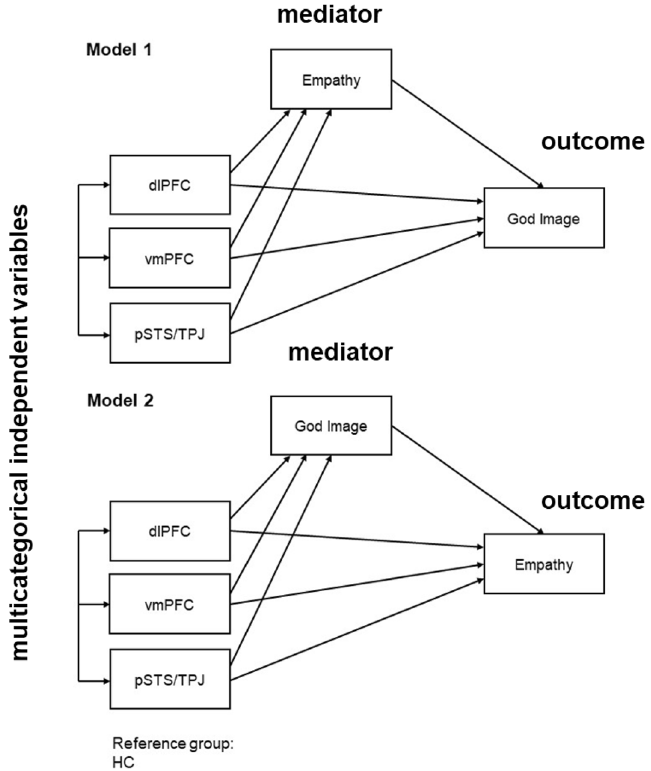
Figure 2. These path diagrams illustrate the two mediation models we used with three multicategorical independent variables, a mediator, and an outcome variable .